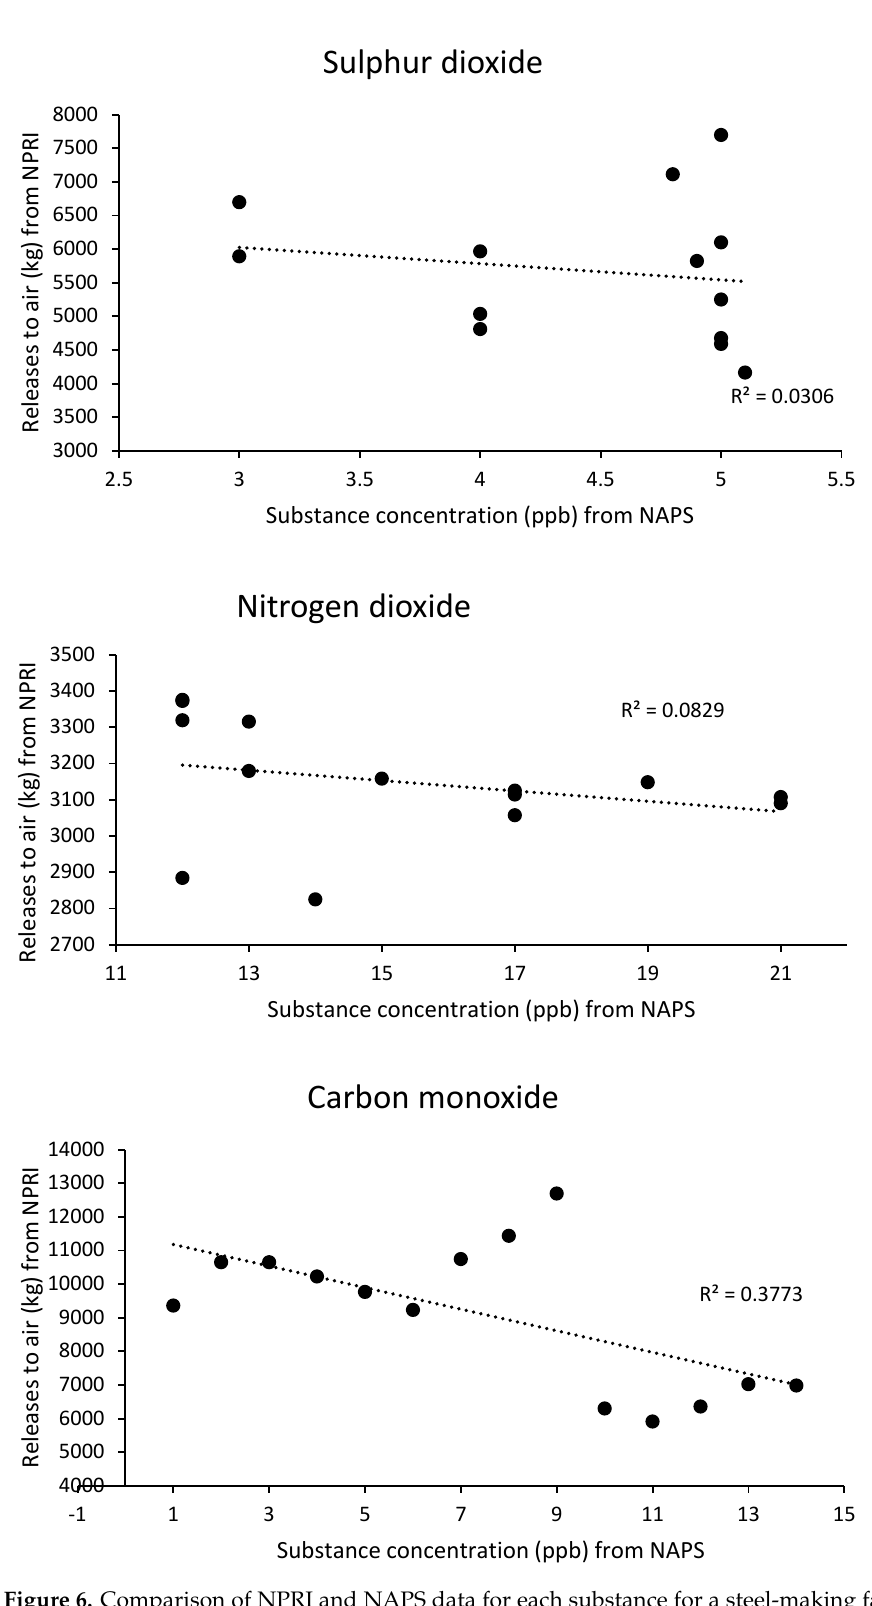
Figure 6. Comparison of NPRI and NAPS data for each substance for a steel-making facility from 2002 to 2015.